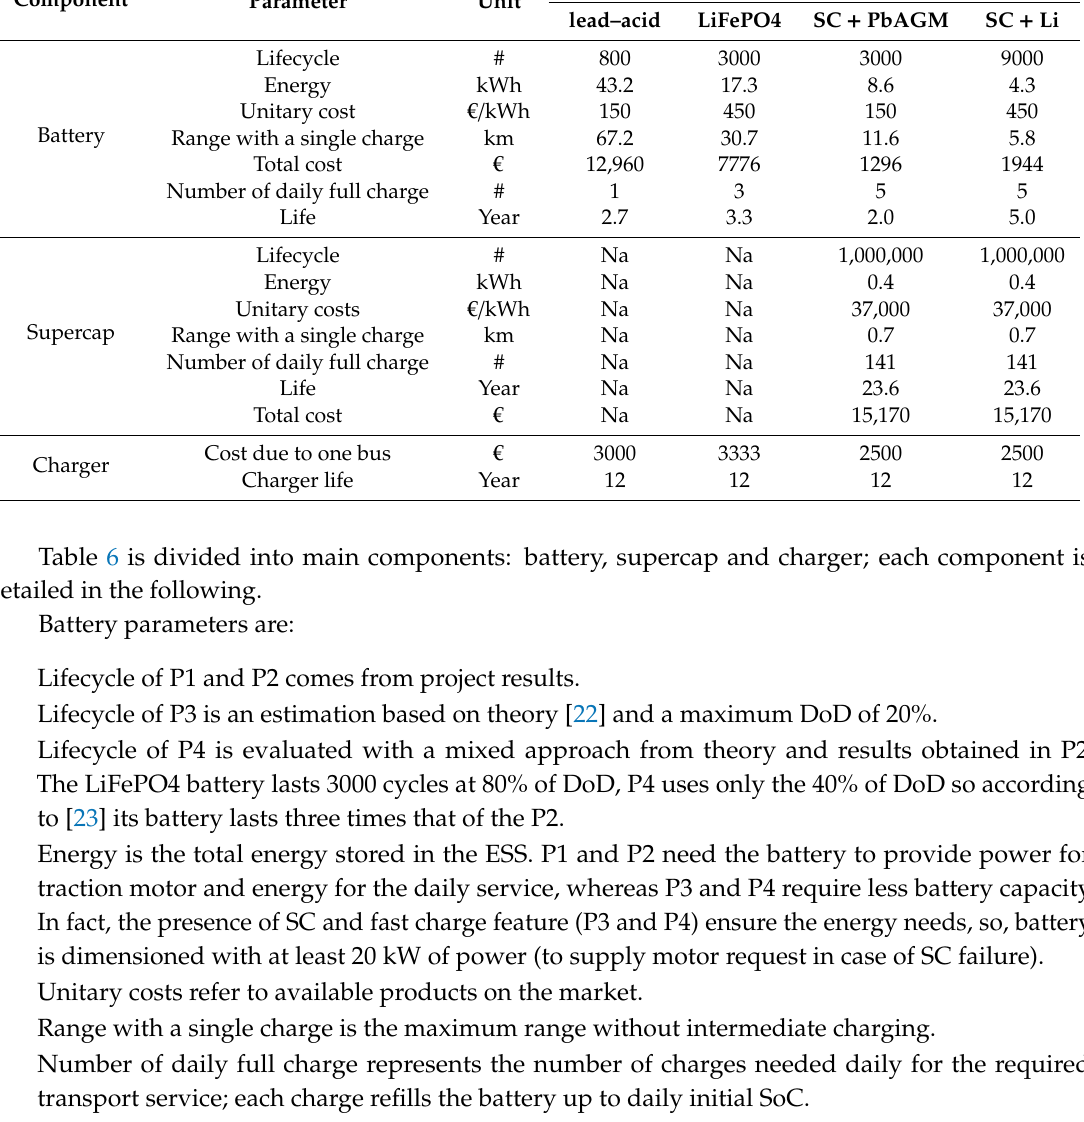
Table 6. Comparison of cost parameters.